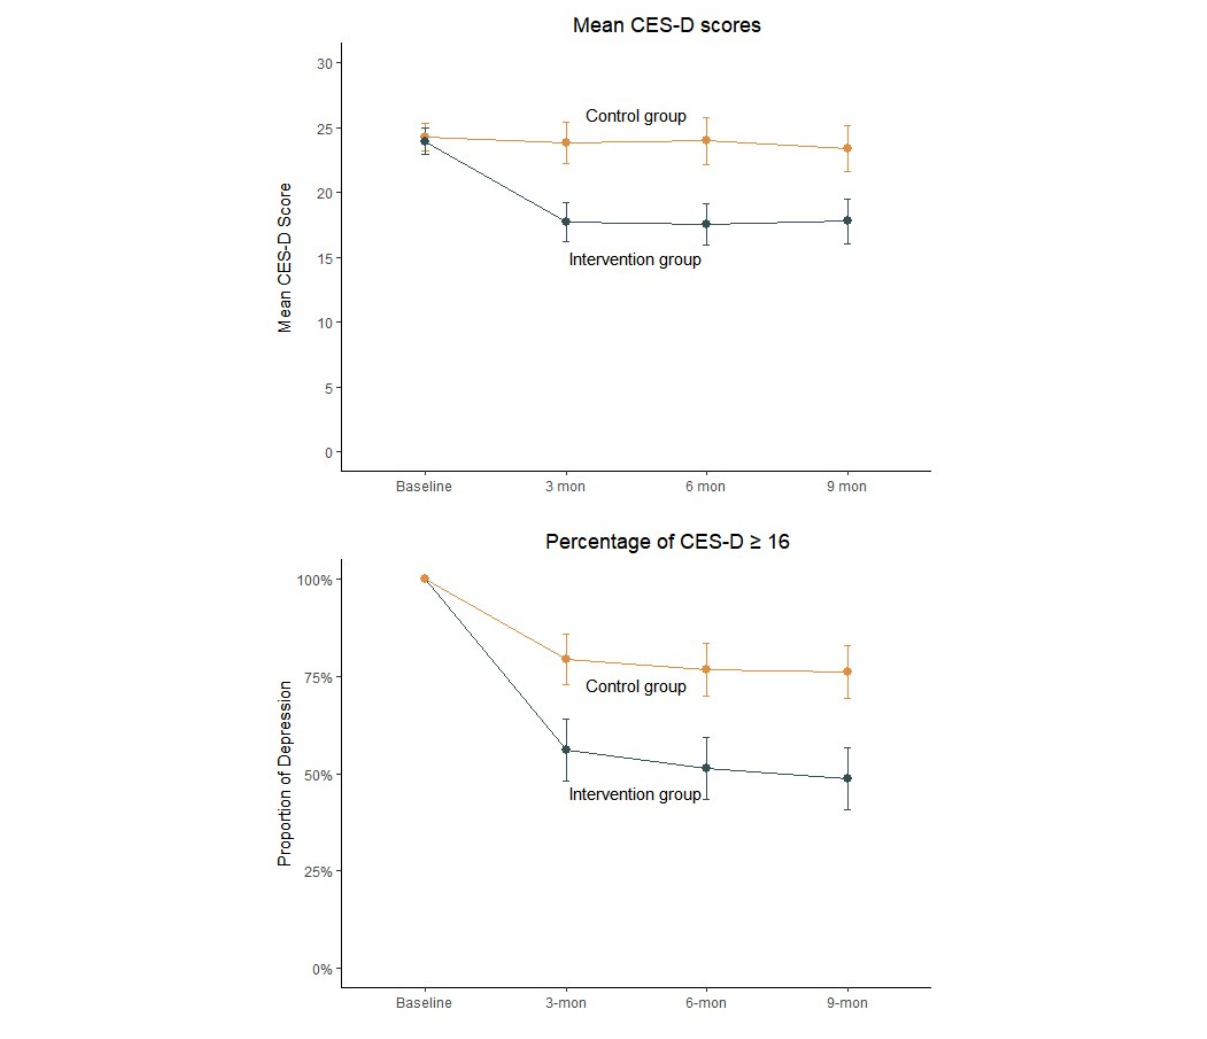
Figure 2. Depression severity and percentage change over time for the intervention group vs the control